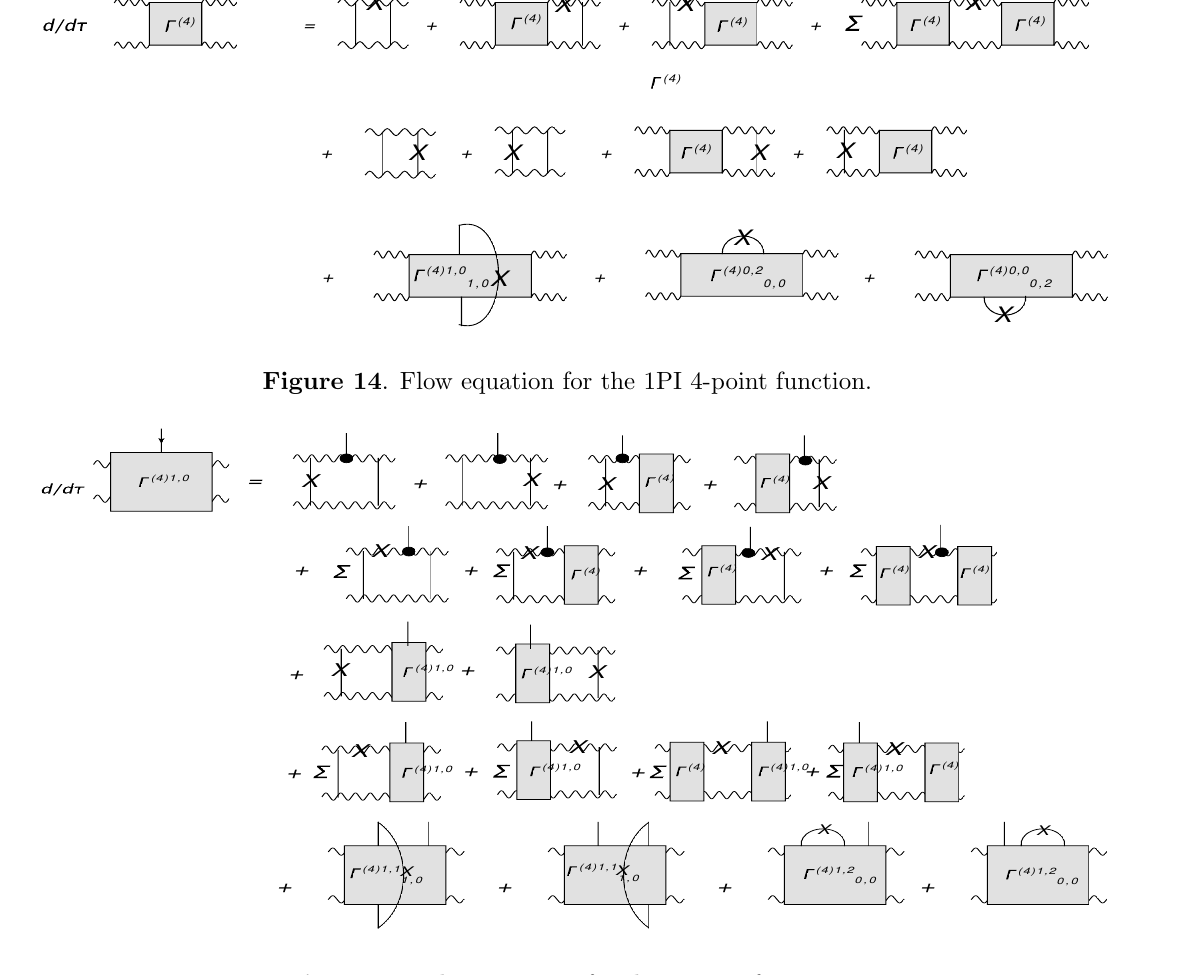
Figure 15 . Flow equation for the 5-point